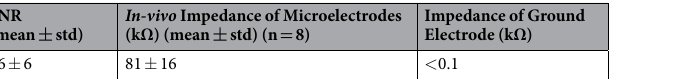
Table 2. Average electrical recording SNR value and impedance of GC microelectrodes arrays implanted in the forelimb area of rat sensory